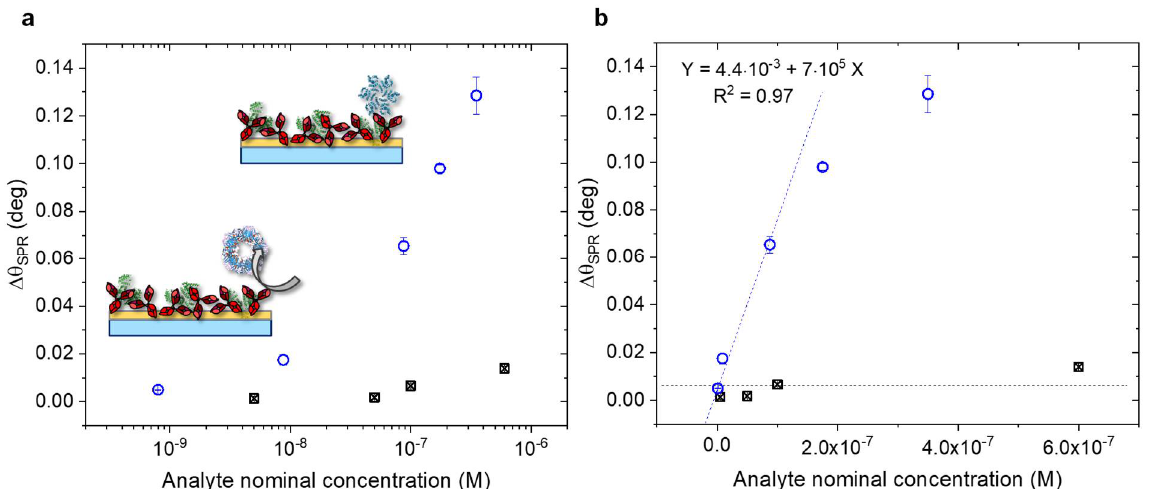
Figure 7. ( a ) SPR angular shift vs nominal concentration of HIV-1 p24 (blue circles) and CRP (black squares) in the cross- reactivity test, performed on physisorbed antibodies (semi-log scale). ( b ) Linear plot of SPR response performed on the modified surface, upon the p24 (blue circles) and CRP (black squares) binding vs, analyte nominal concentration. The regression of the linear portion of p24 response is shown as a blue dotted line; the average signal of the negative control is depicted as a black dotted line. The average value of three replicate analysis and their standard deviation are reported.